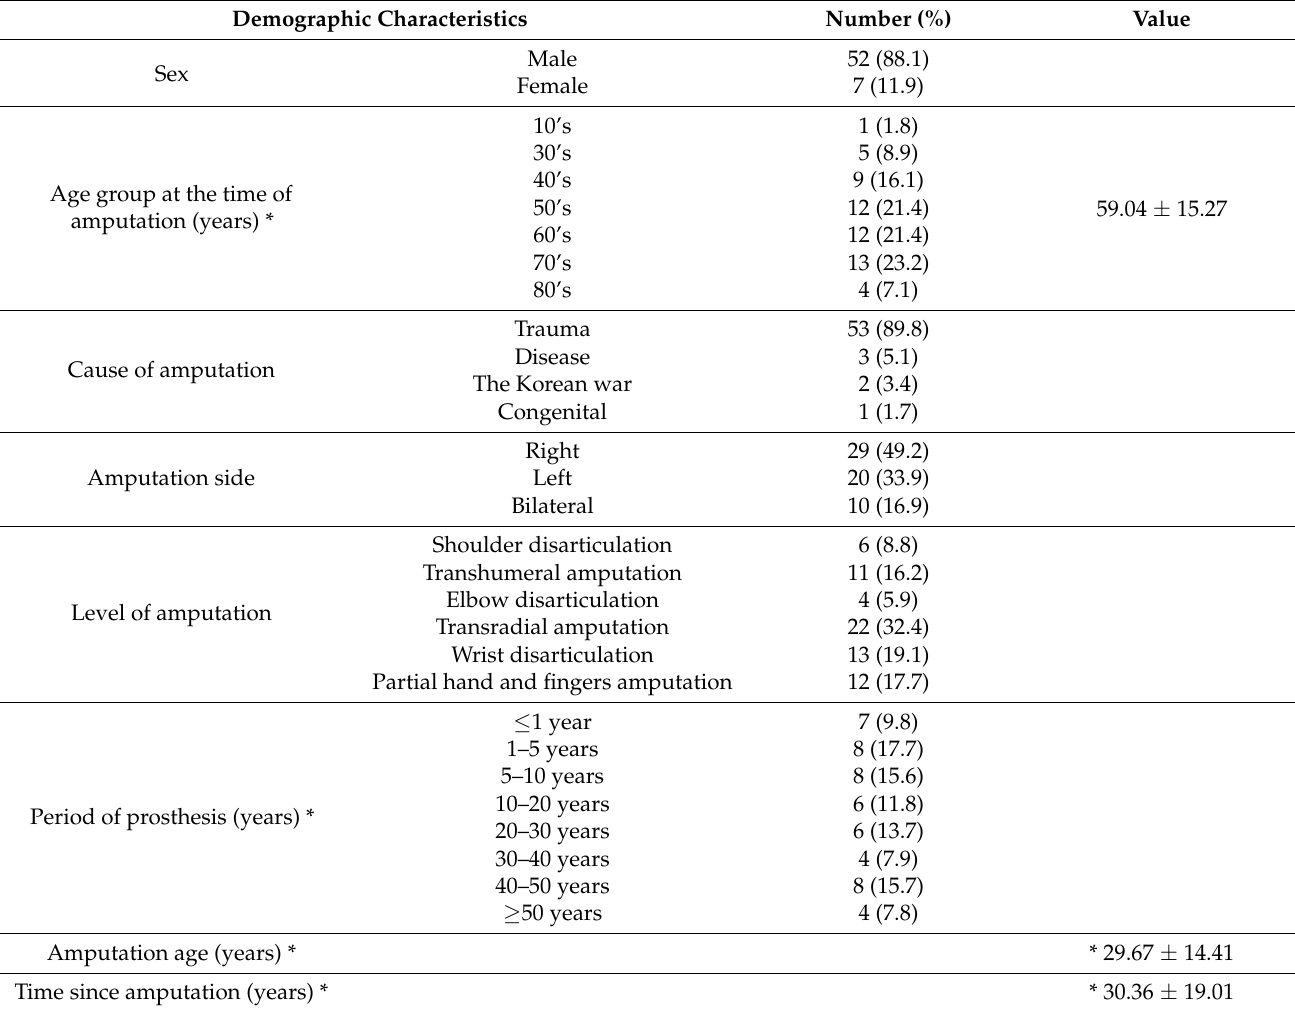
Table 1. General characteristics of the respondents ( n =